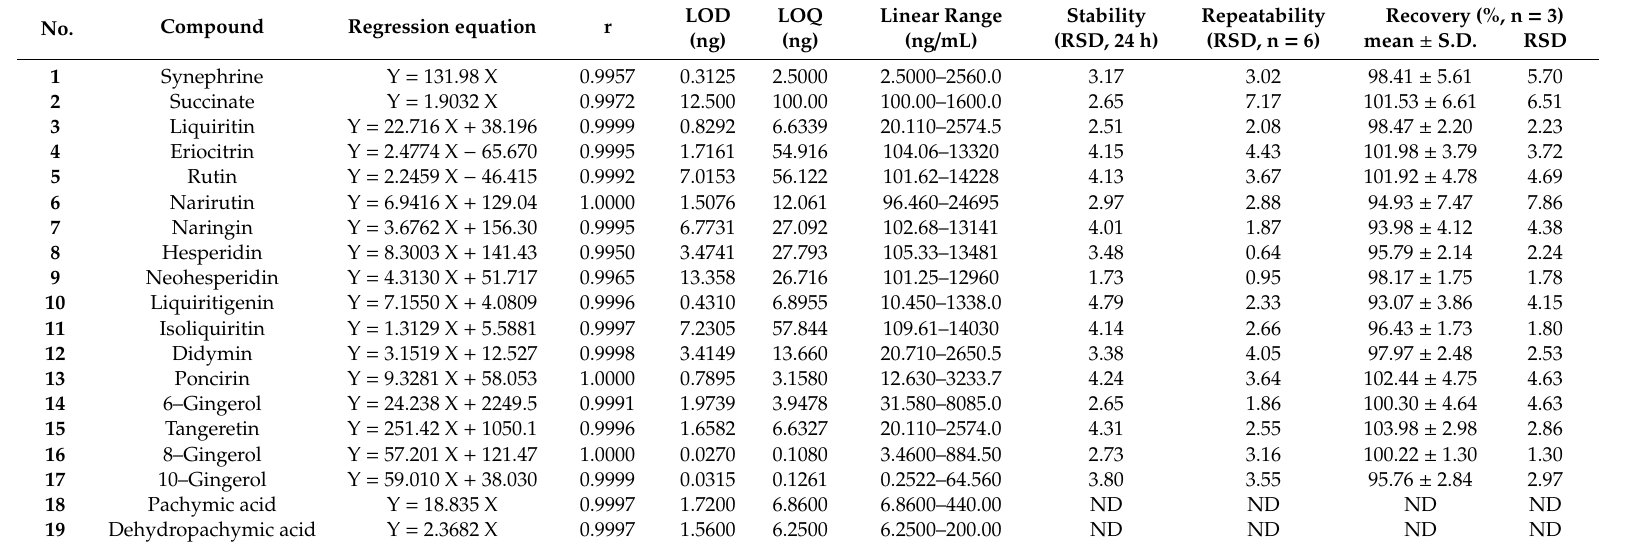
Table 2. Regression data, LODs, LOQs, stabilities, repeatabilities and recoveries for the 19 components of